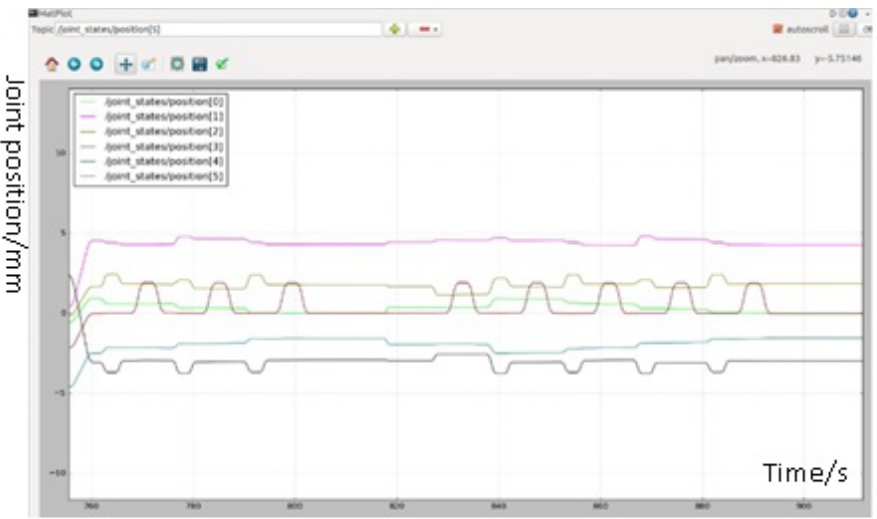
Fig. 4 The change curve of the joint position of the robotic